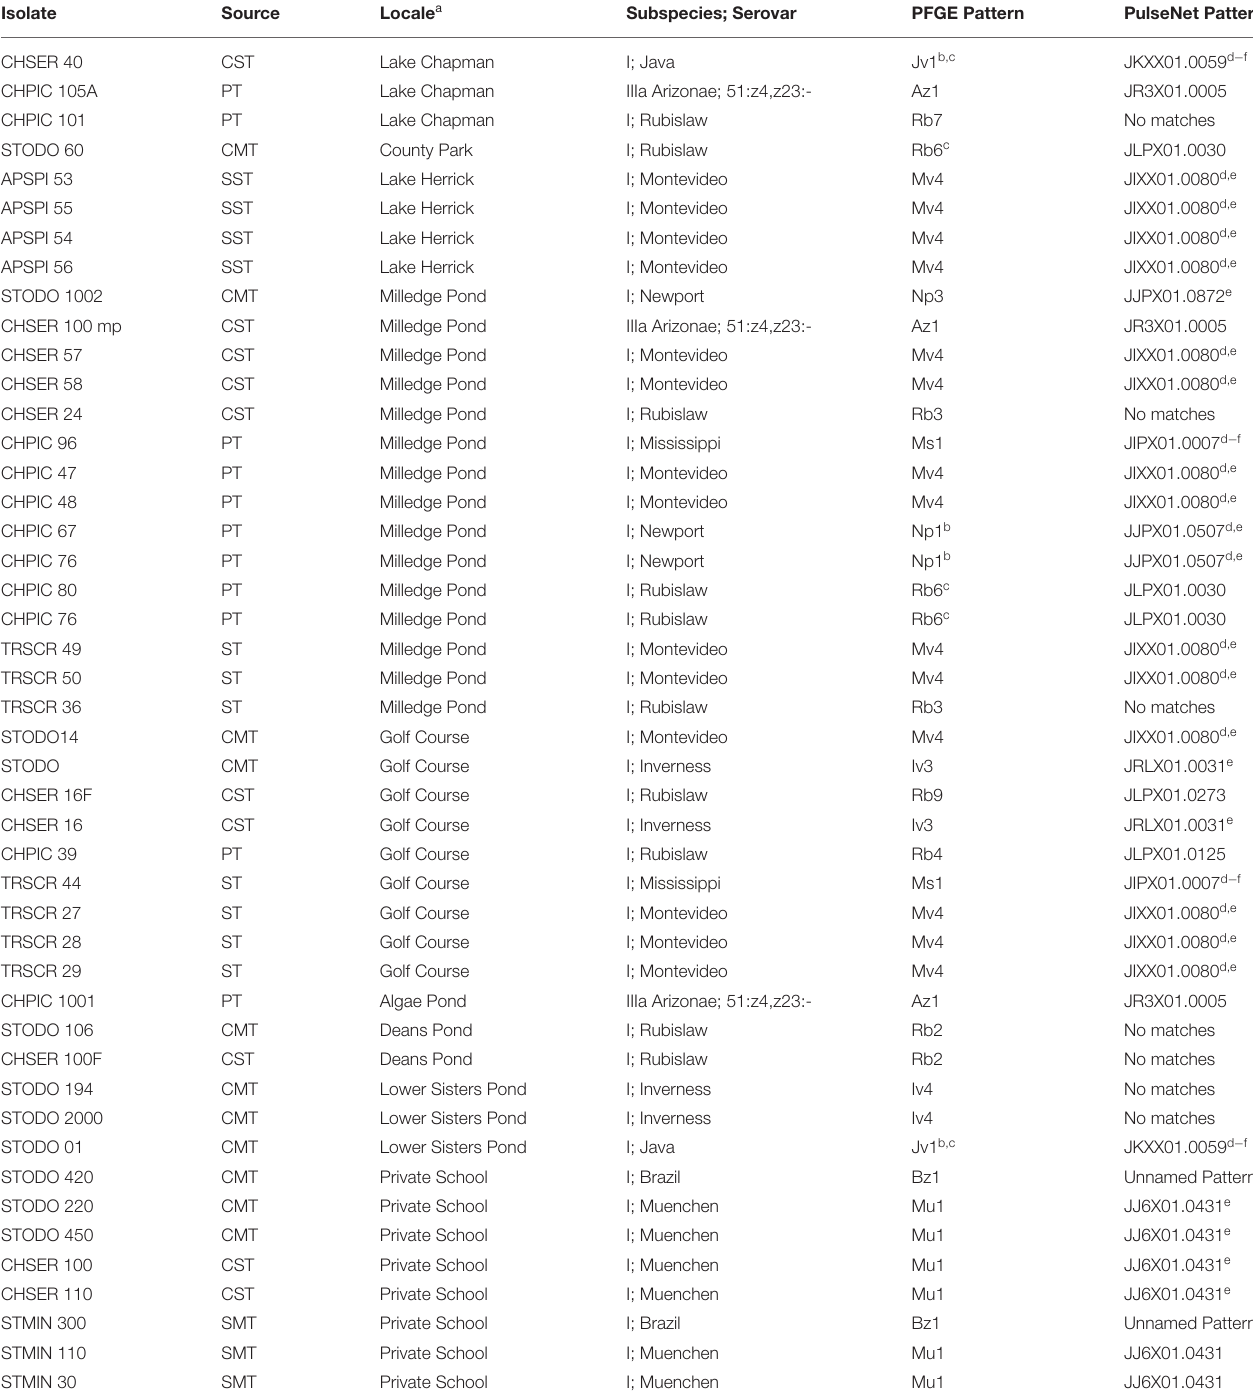
TABLE 3 | Matching Pulsed Field Gel Electrophoresis (PFGE) Patterns between Salmonella enterica isolated from turtles and humans.